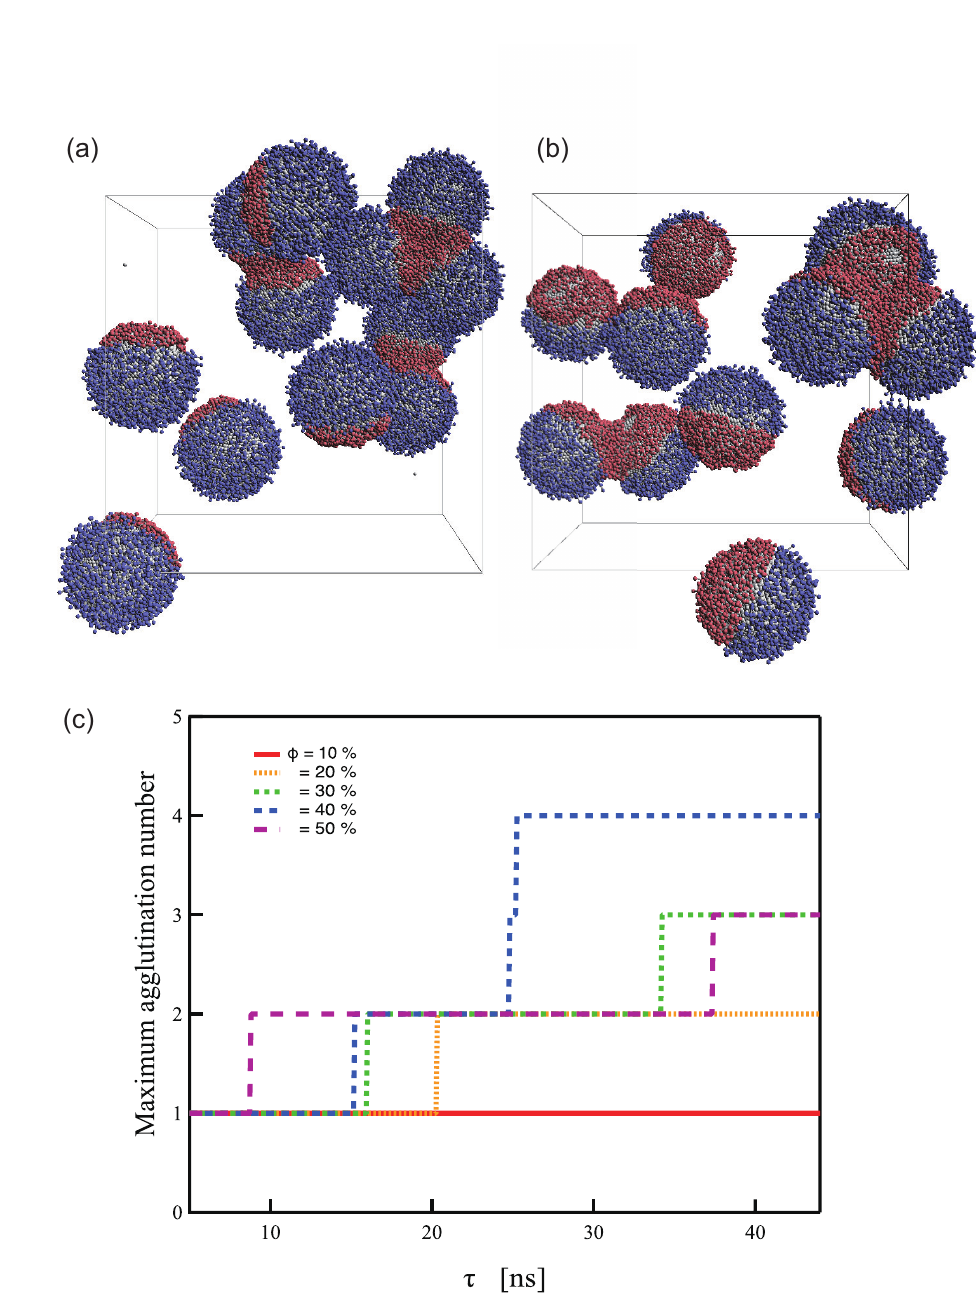
Figure 6. Representative snapshots of PTNPs in equilibrium at φ = ( a ) 30% ( b ) 50% and ( c ) Maximum agglutination number at each coverage